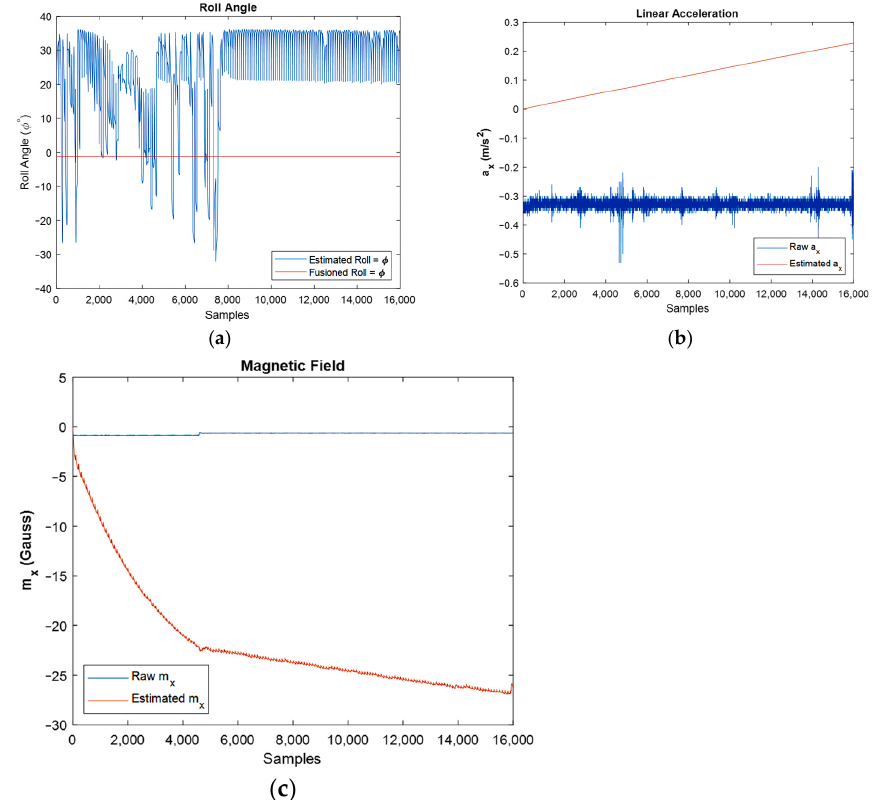
Figure 19. The effect of changing initial conditions in a wrong manner on orientation ( a ), linear acceleration ( b ), and magnetic field ( c ).